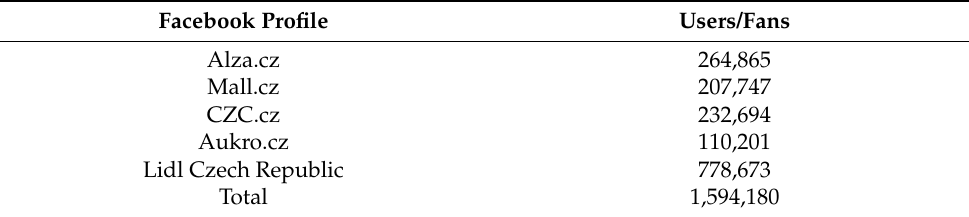
Table 1. Structure of the research sample. Source: authors’ own processing based on [32]. Facebook